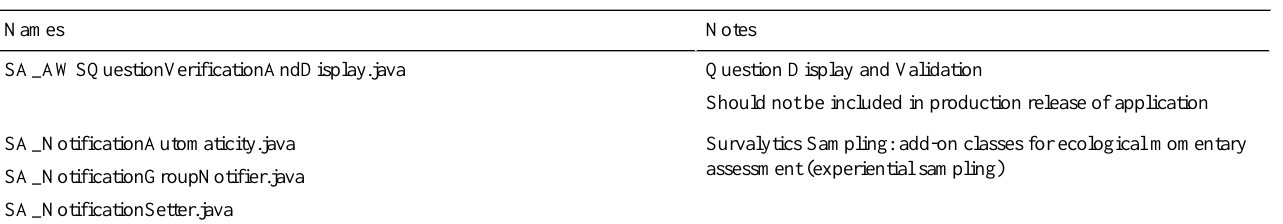
Table 3. Supplemental Survalytics Java